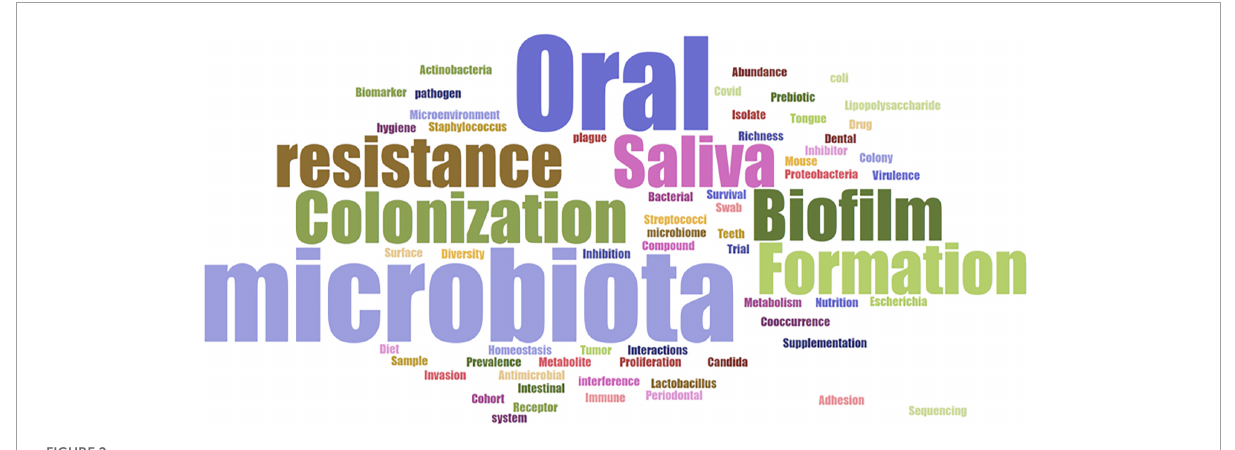
FIGURE2 Word cloud based on the main keywords related to the review